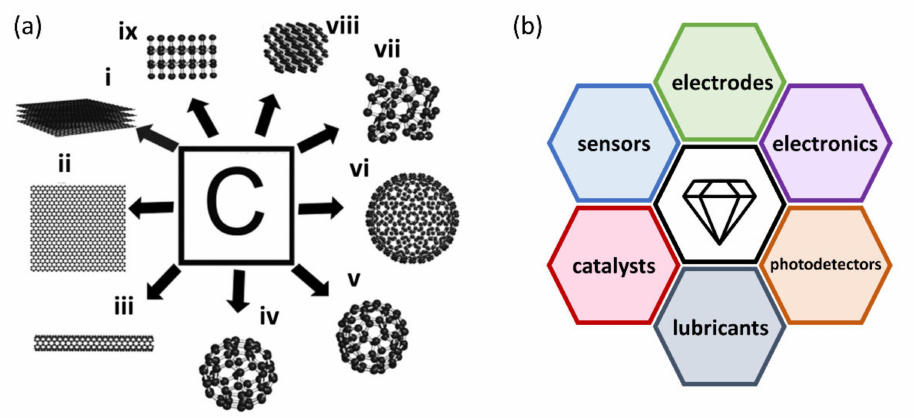
Figure 1. ( a ) Different carbon allotropes: (i) graphite, (ii) GN, (iii) carbon nanotube, (iv) fullerene C 60 , (v) C 70 , (vi) C 540 , (vii) amorphous carbon, (viii) lonsdaleite, and (ix) diamond. ( b ) Schematic presentation of the application areas of the GN—diamond